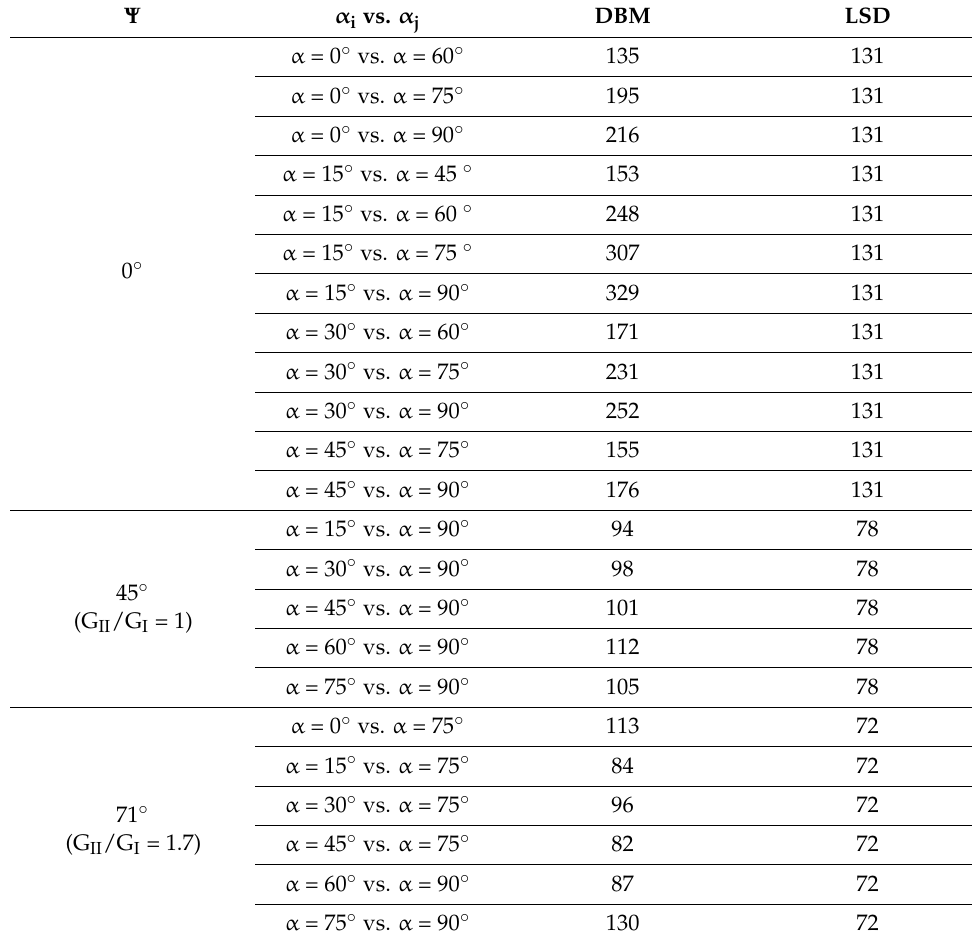
Table 3. Laminate A: statistically significant